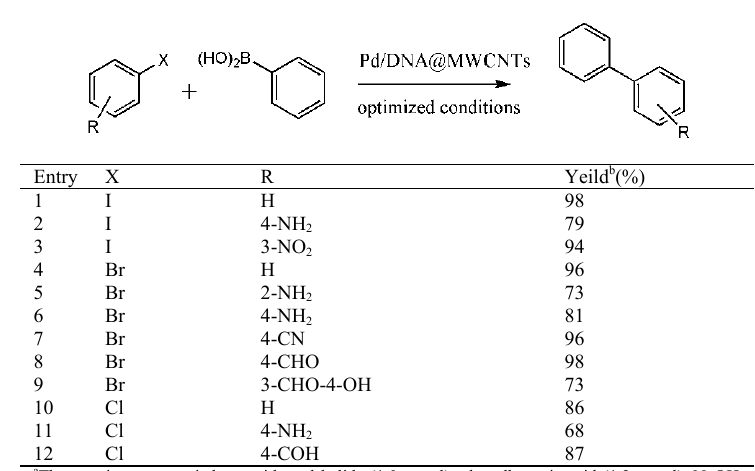
Table 2. Suzuki cross-coupling of various aryl halides in the presence of the catalyst.